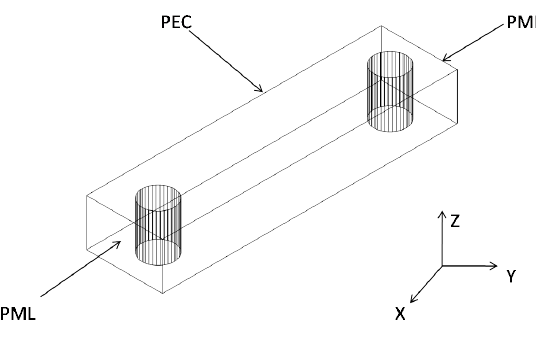
Figure 2: Top view of a unit cell of periodic